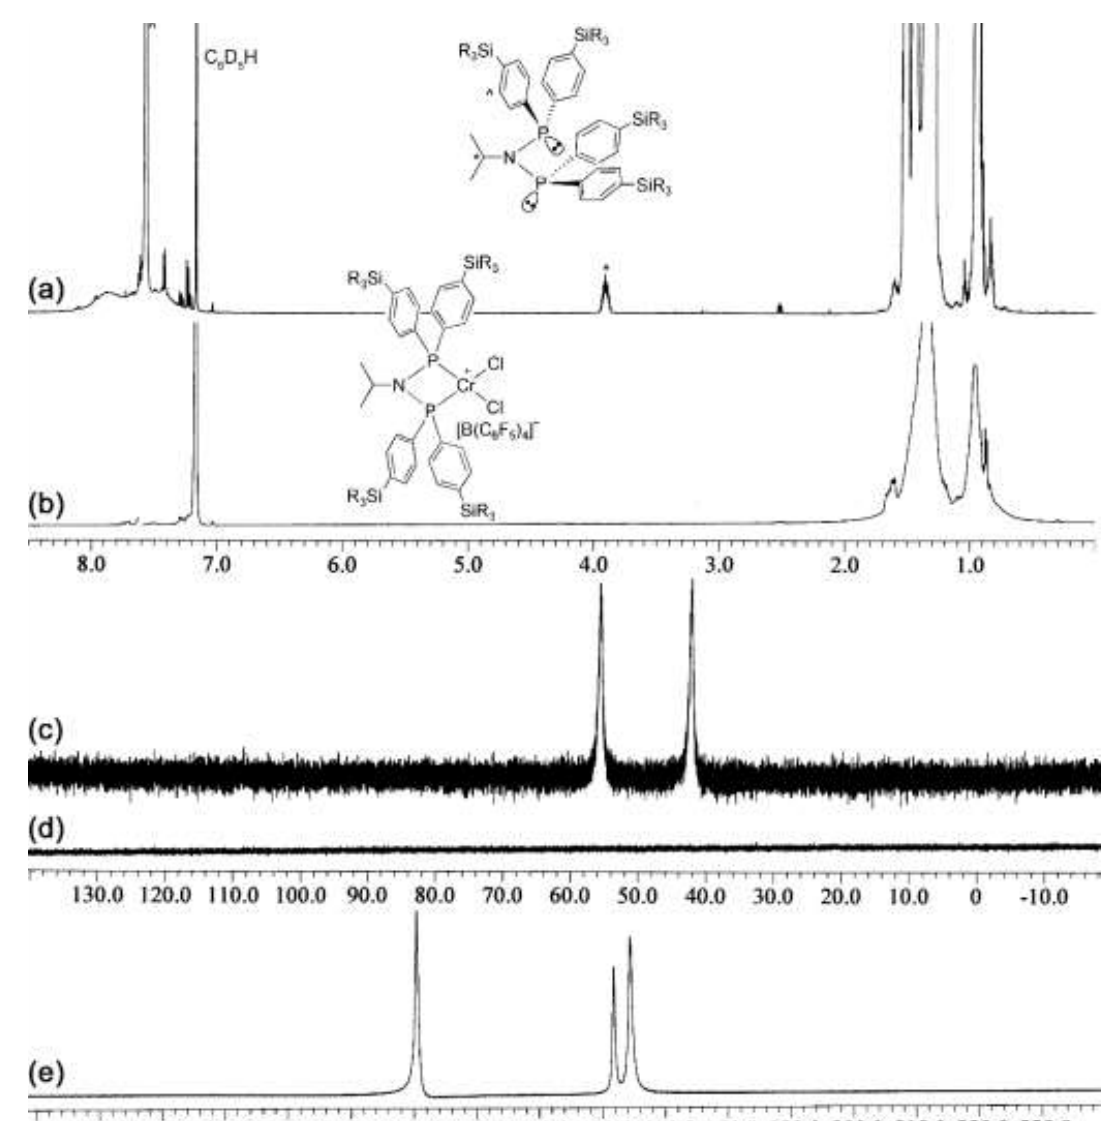
Figure 1. 1 H NMR spectra of 3 and [ 3 − CrCl 2 ] + [B(C 6 F 5 ) 4 ] – ( a , b ), 31 P NMR spectra of 3 and [ 3 − CrCl 2 ] + [B(C 6 F 5 ) 4 ] – ( c , d ) and 19 F NMR spectrum of [ 3 − CrCl 2 ] + [B(C 6 F 5 ) 4 ] – ( e